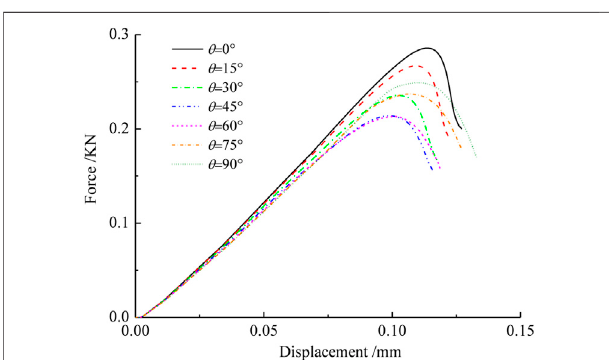
FIGURE5| Force – displacementcurves ofthedisksamplewithdifferent pre-existing cracks.